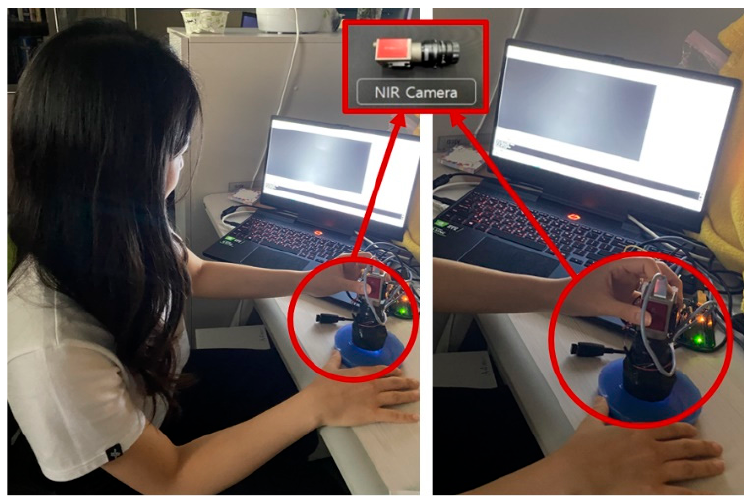
Figure 17. Optical tactile imaging.